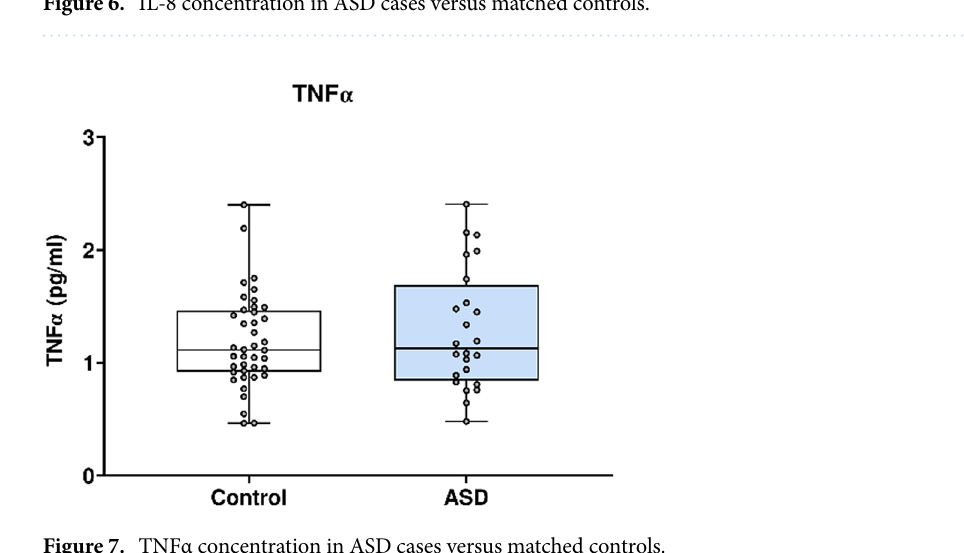
Figure 7. TNFα concentration in ASD cases versus matched controls.